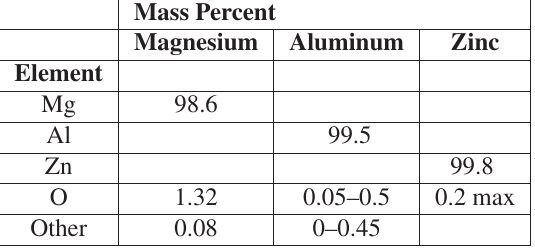
Table 1. Chemical composition of base powders used to form P/M AZ31 alloy, as reported by the